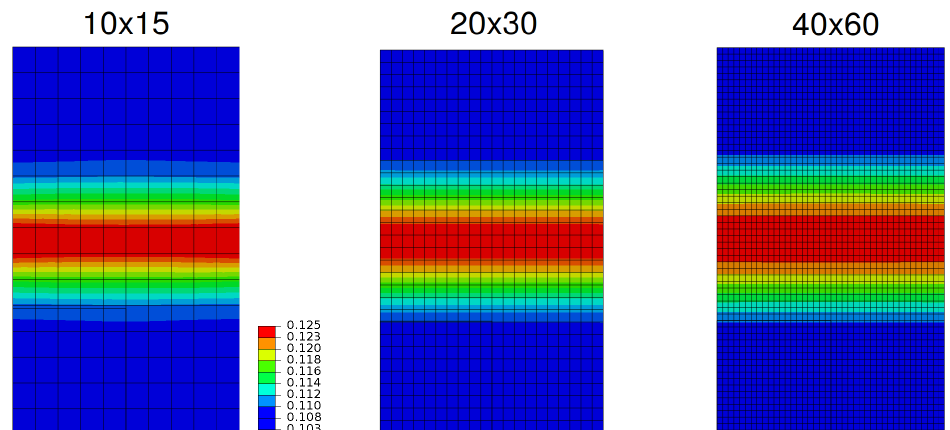
Figure 5. Mesh independent solutions for the cleavage problem analyzed with a constant parameter set with varying mesh density (contour maps of d